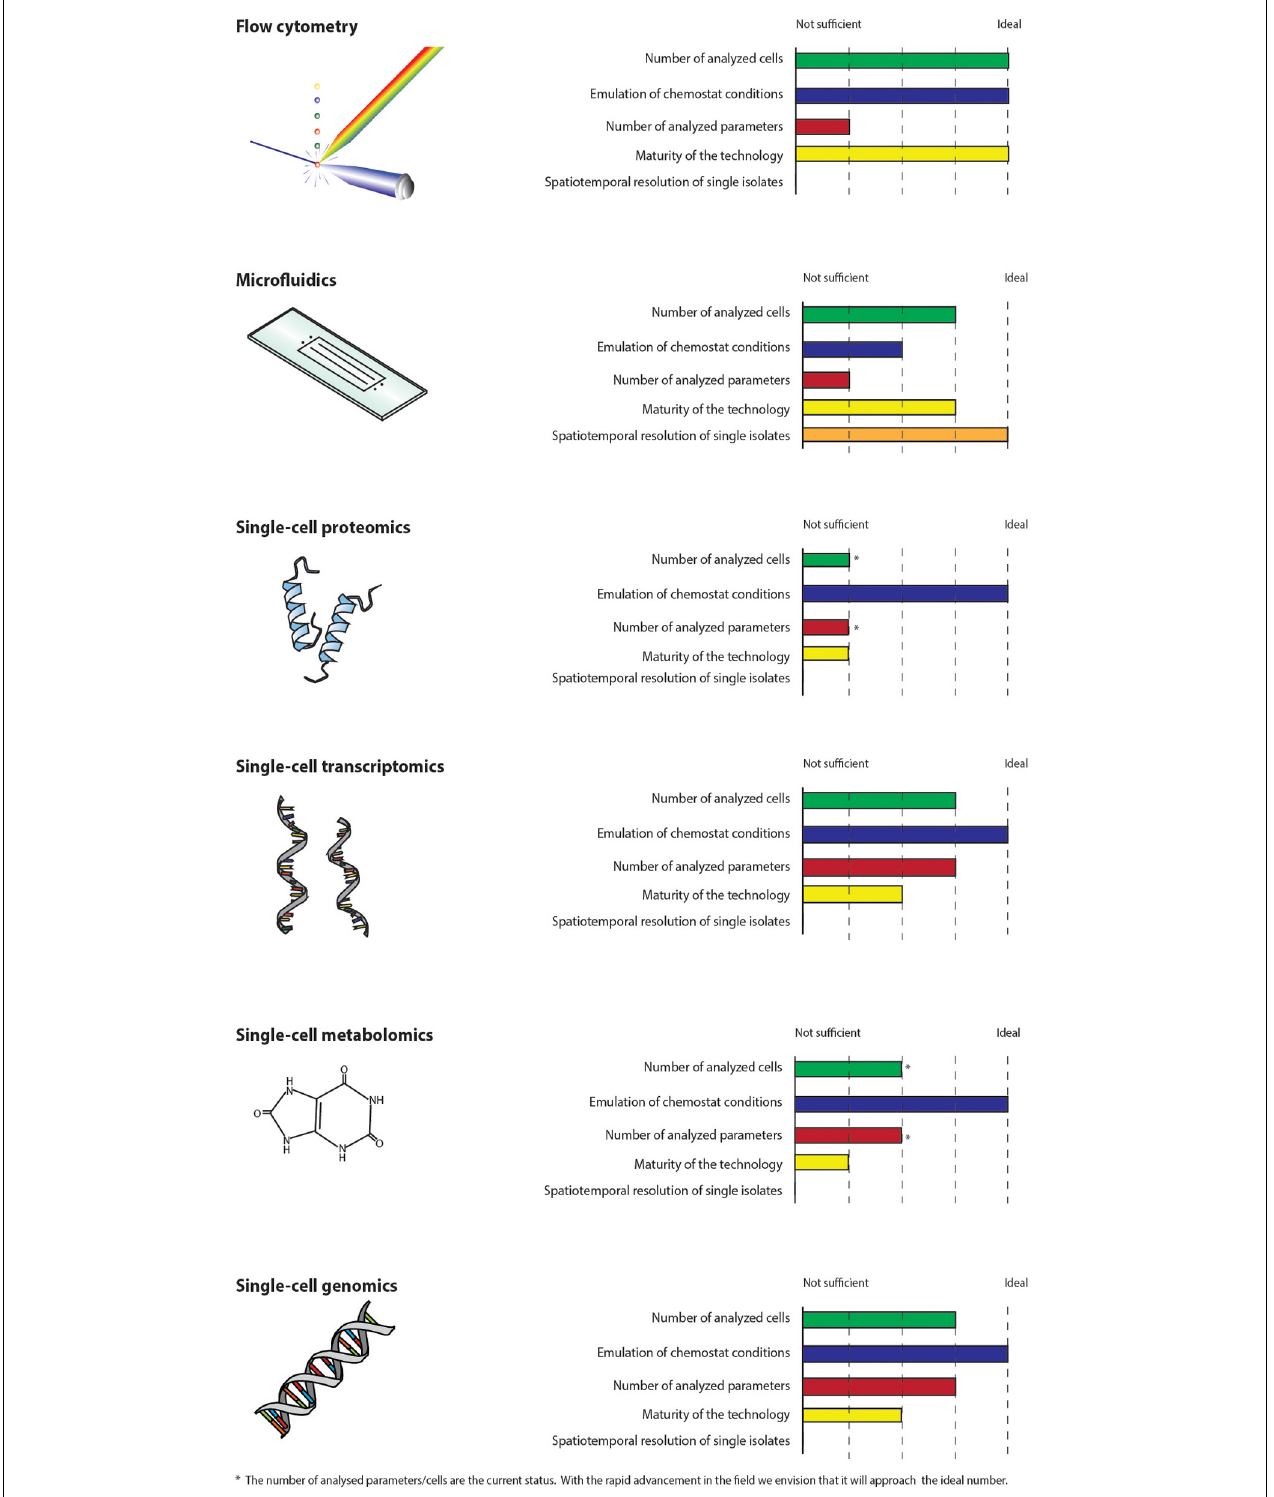
FIGURE 2 | Single-cell technologies are compared on a scale from not sufficient to ideal with respect to how suited they are for the study of adaptation in chemostats. The parameters used for the comparison are: the number of analyzed cells, how well the technologies emulate chemostat conditions, the number of parameters which can be analyzed, how mature the technologies are and whether the technologies can be used to study individual cells by precise spatial and temporal control. None of the technologies fulfill all these criteria at the moment.